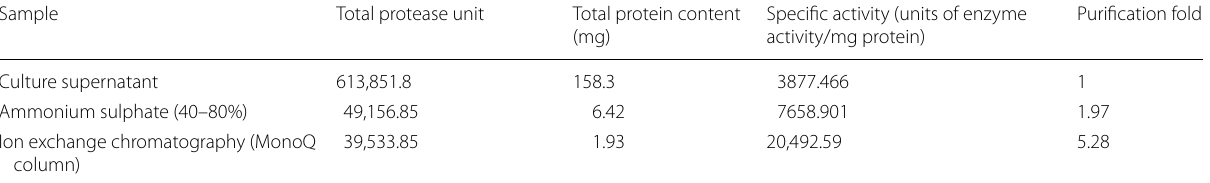
Table 1 The parameters of purification of serratiopeptidase from culture supernatant up to ion-exchange chromatography Sample